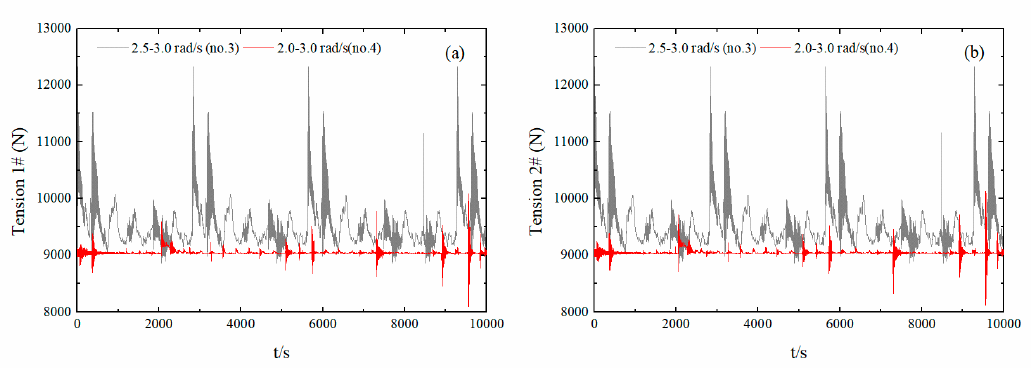
Figure 22. Anchor-chain tension time-history curves. (Sub-figures: ( a ) time-history curves of anchor chain I tension; ( b ) time-history curves of anchor chain II tension.).